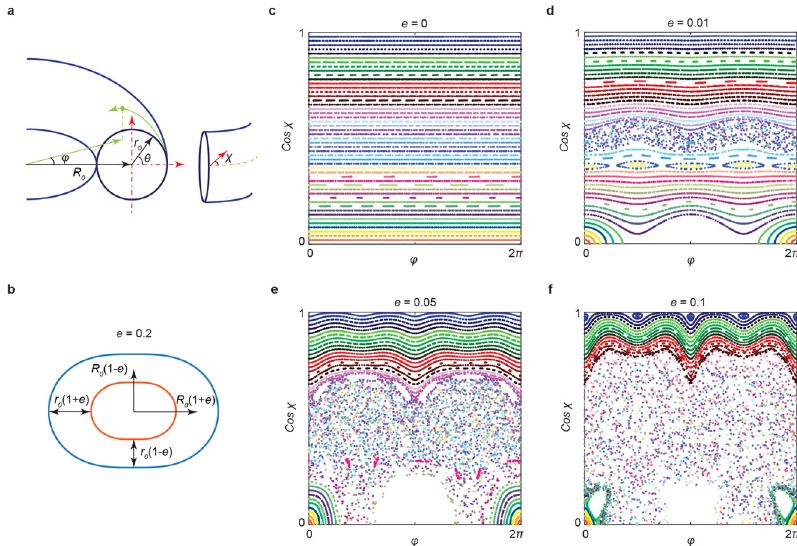
Figure 1: Schematics of the deformed toroidal manifoldand the chaotic transition of the billiard. (a) Parametrization of the toroidal surface. (b) Schematics illustrating the toroidal inner and outer equators with a quadrupolar deformation, parameterized by deformation size parameter “ e ” . (c) Phase space diagram with no